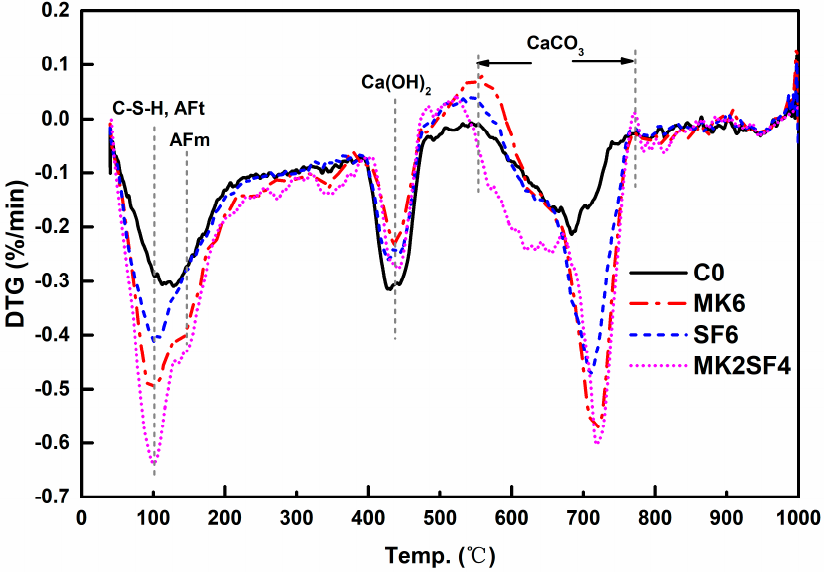
Figure 11. DTG (derivative thermogravimetry) curves of specimens after curing for 28 days.